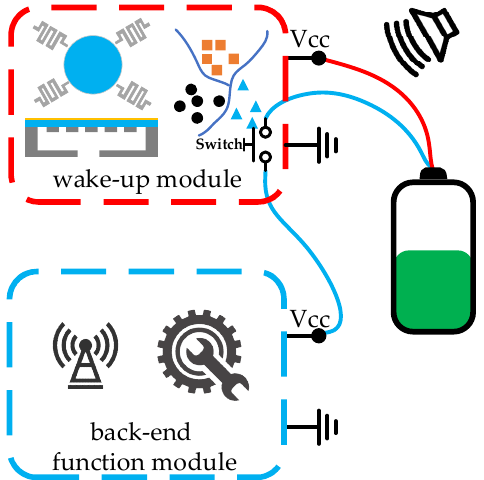
Figure 20. Architecture 3: low-power recognition and zero-power sleep.